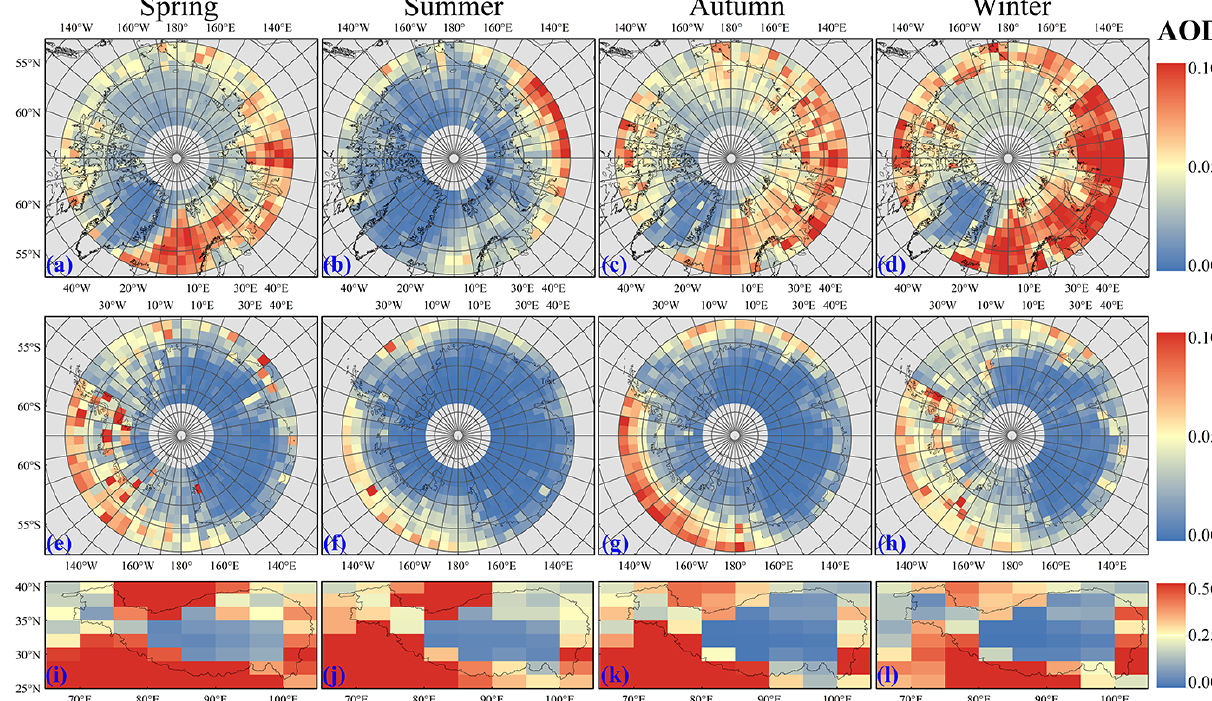
Figure 2. Seasonally averaged AOD distribution for 13 years (June 2006 to December 2019) over the Arctic, Antarctic and TP. Four columns represent four seasons. Panels (a–d) , (e–h) and (i–l) represent the spatial distribution of aerosols in the Arctic, Antarctic and TP, respectively.